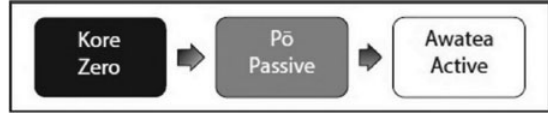
Right Shift in The ZePA Model (Higgins & Rewi,